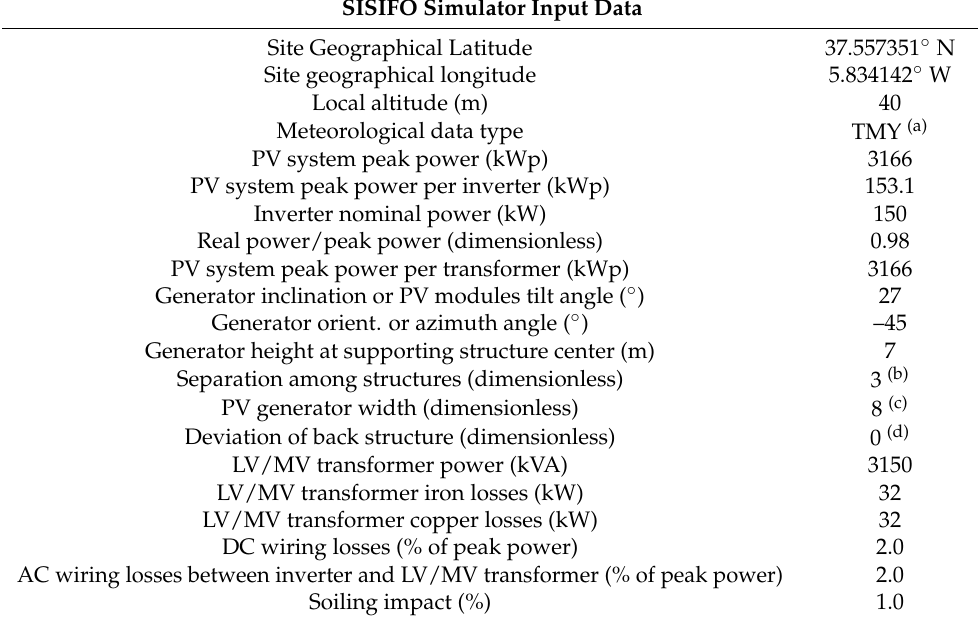
Table 1. Input data for PV simulation of a 5.7 ha agro-photovoltaic plant oriented due Southwest, in Brenes (Seville, Spain).